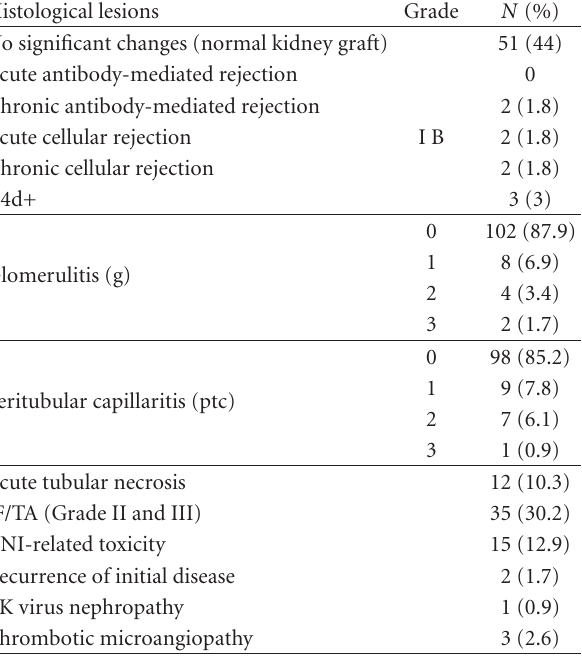
Table 4: Histological results of surveillance biopsies at one year posttransplant (central reading) among adequate samples ( n =